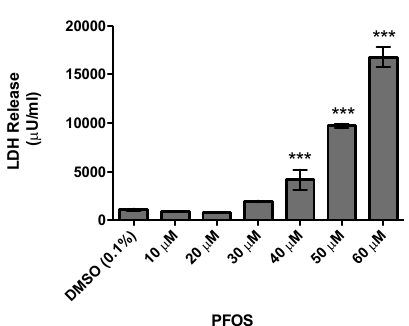
Figure 1. Acute exposure to perfluoroctane sulfonate (PFOS) is cytotoxic to undifferentiated SH-SY5Y dopaminergic neuroblastoma cells, as measured by lactate dehydrogenase (LDH). Beginning at 40 µ M, PFOS treatment resulted in a statistically significant increase in toxicity, compared with dimethylsulfoxide (DMSO) treated cells. The amount of toxicity continued to increase with elevated concentrations of PFOS. Columns represent the means of raw data + SEM of eight experimental replicates per treatment group performed over three separate experiments. *** Values statistically significant from DMSO control ( p < 0.001).